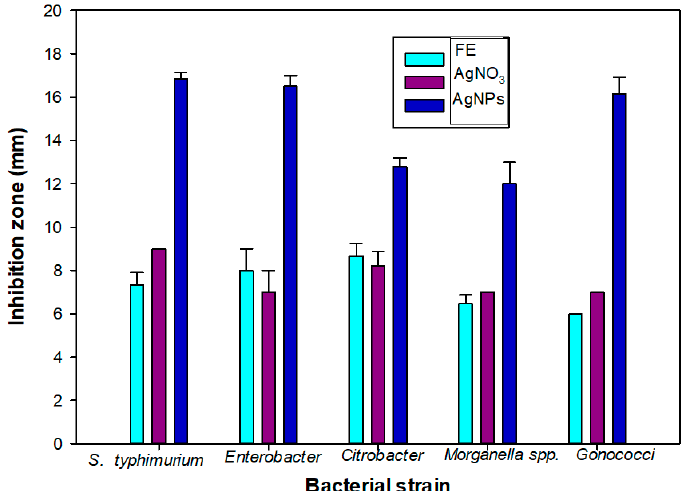
Figure 6. Bacterial growth inhibition zone of flower extract (FE), silver nitrate and silver nanoparticles against pathogenic bacteria ( Salmonella typhimurium , Enterobacter , Citrobacter spp., Morganella spp. and Gonococci).